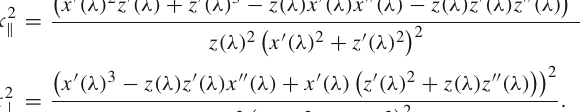
Fig. 11 Four different ways to describe the same bulk point x m ( 0 , 0 , 2 ) , marked in red, and a small sample of the corresponding geodesics, in orange. Shown in green on the AdS boundary is the curve traced by the center of the intervals in the CFT, x entire set of geodesics follows via (96)–(97). The gray dotted curves